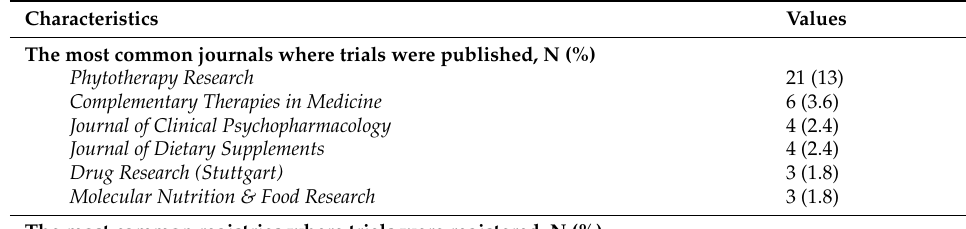
Table 1. Characteristics of included studies (N =